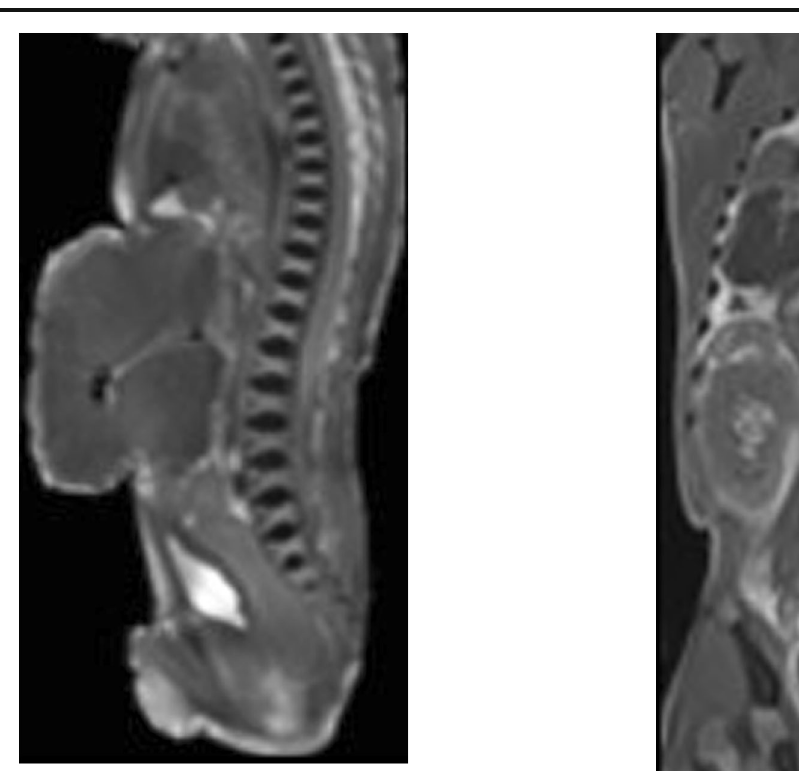
Fig. 10 Sagittal T2-W image of a 25 weeks gestation fetus with an abdominal wall defect and a large hepatocele